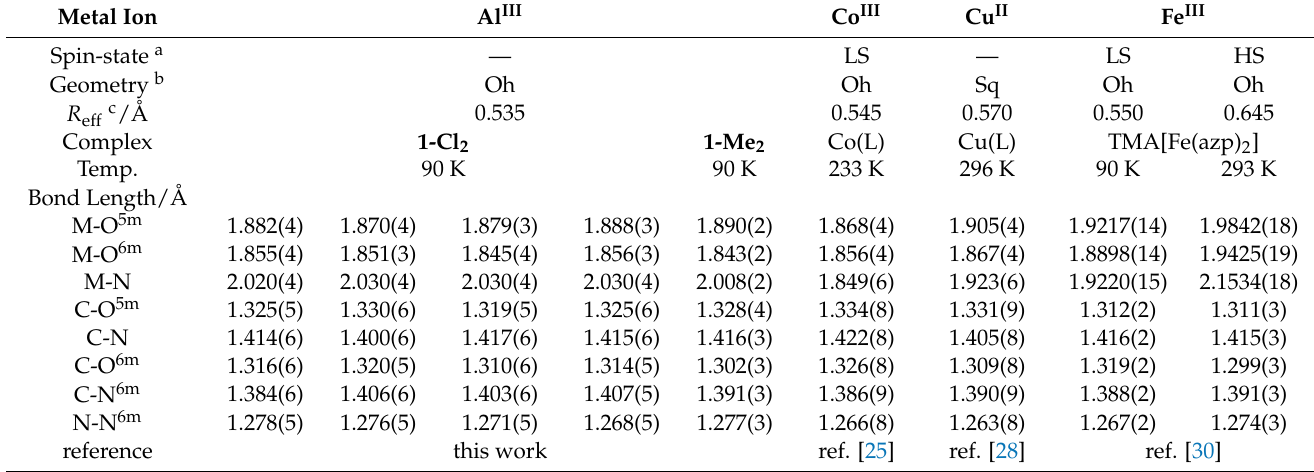
coordination for the homoleptic 1:2 Al III complex with an azp derivative ligand by both the solid ‐ state and solution ‐ state NMR spectroscopy and also observed a similar higher ‐ field shift [42]. The present observations suggest that all the Al III complexes 1 and 2 re ‐ tained the homoleptic octahedral coordination structure in solution.